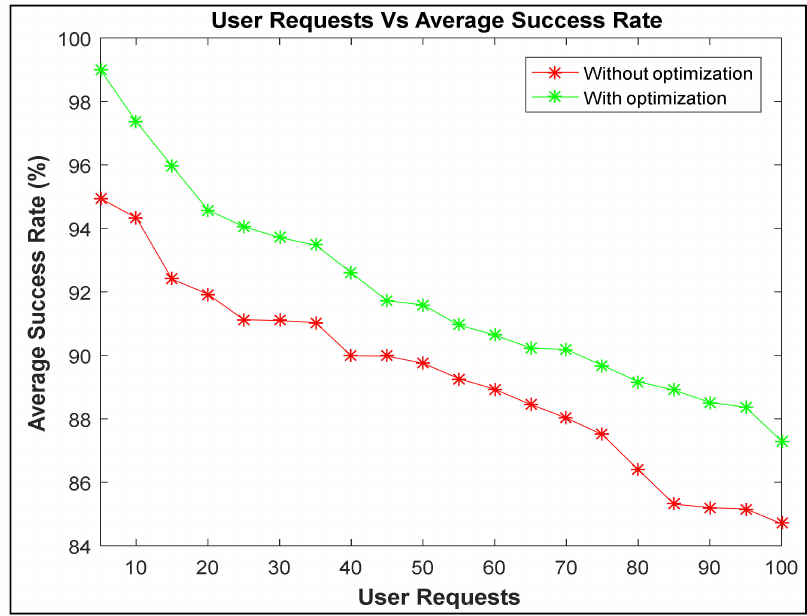
Figure 8. Average Success